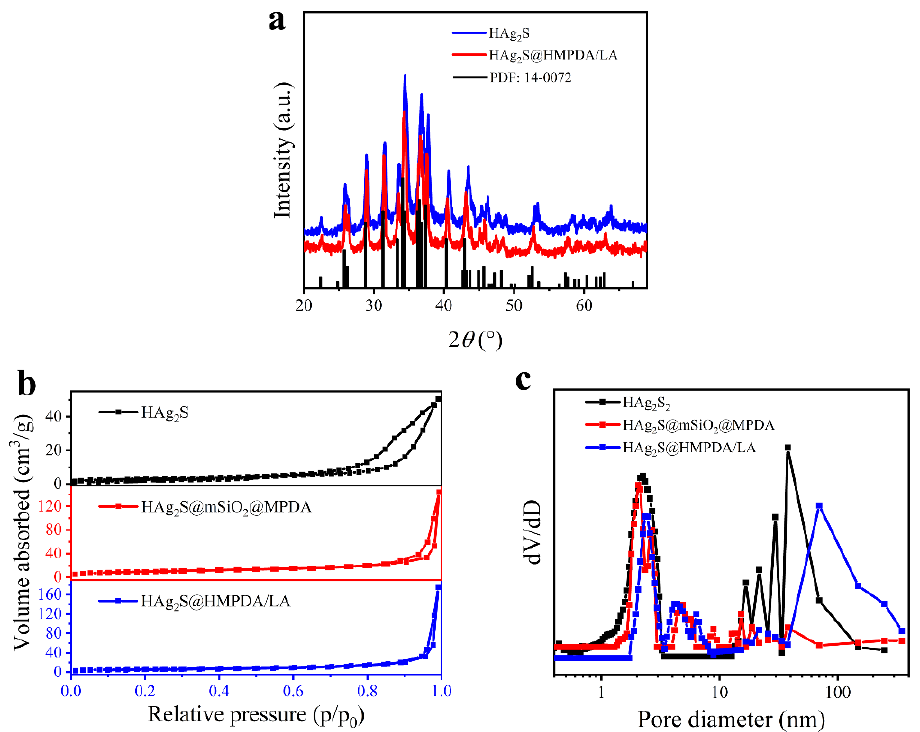
Figure 5. XRD patterns ( a ), N 2 adsorption/desorption isothermals ( b ), and pore size distribution ( c ) of samples.